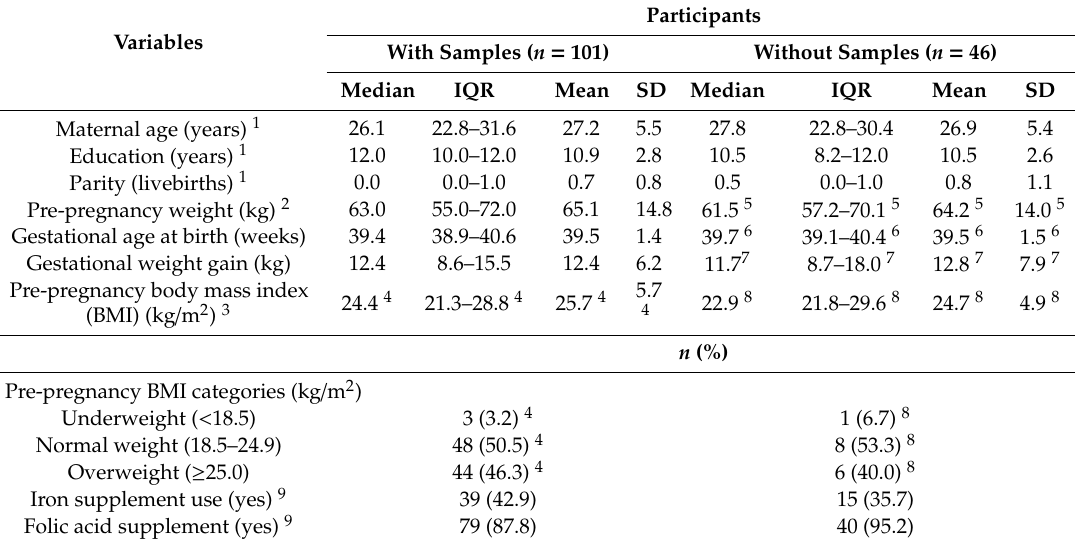
Table 1. Demographic and anthropometric profile and supplement use of women from the Brazilian cohort, Rio de Janeiro,